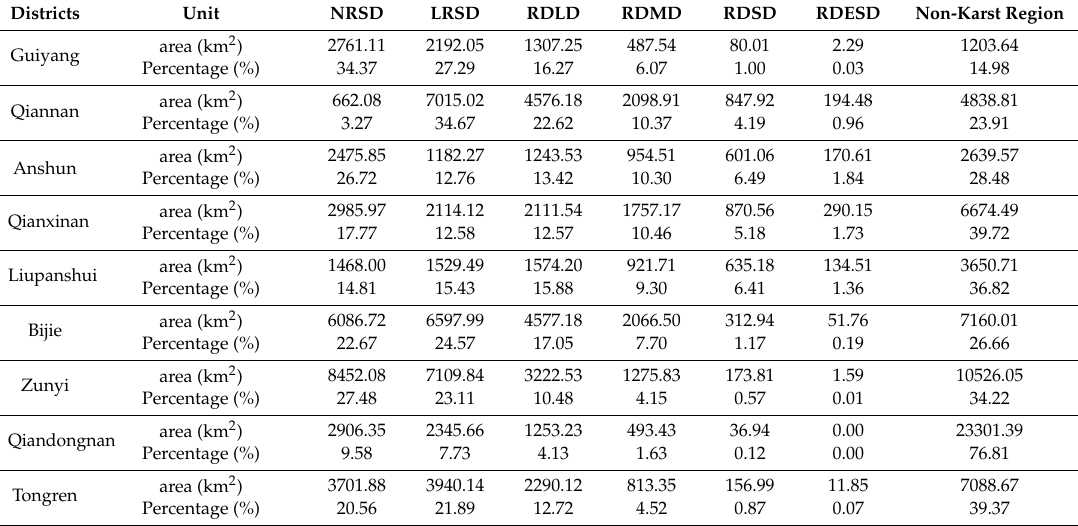
Table 1. Distribution of rocky desertification within the study area